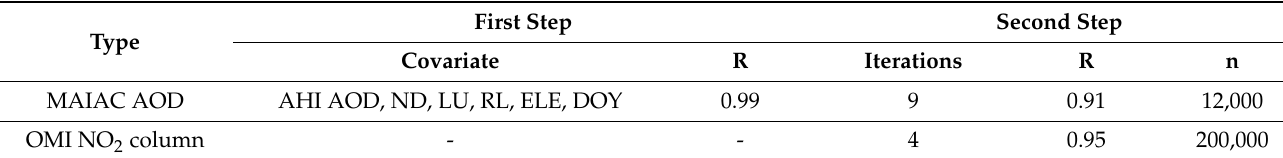
Table 1. Iterative TWS recovery results.